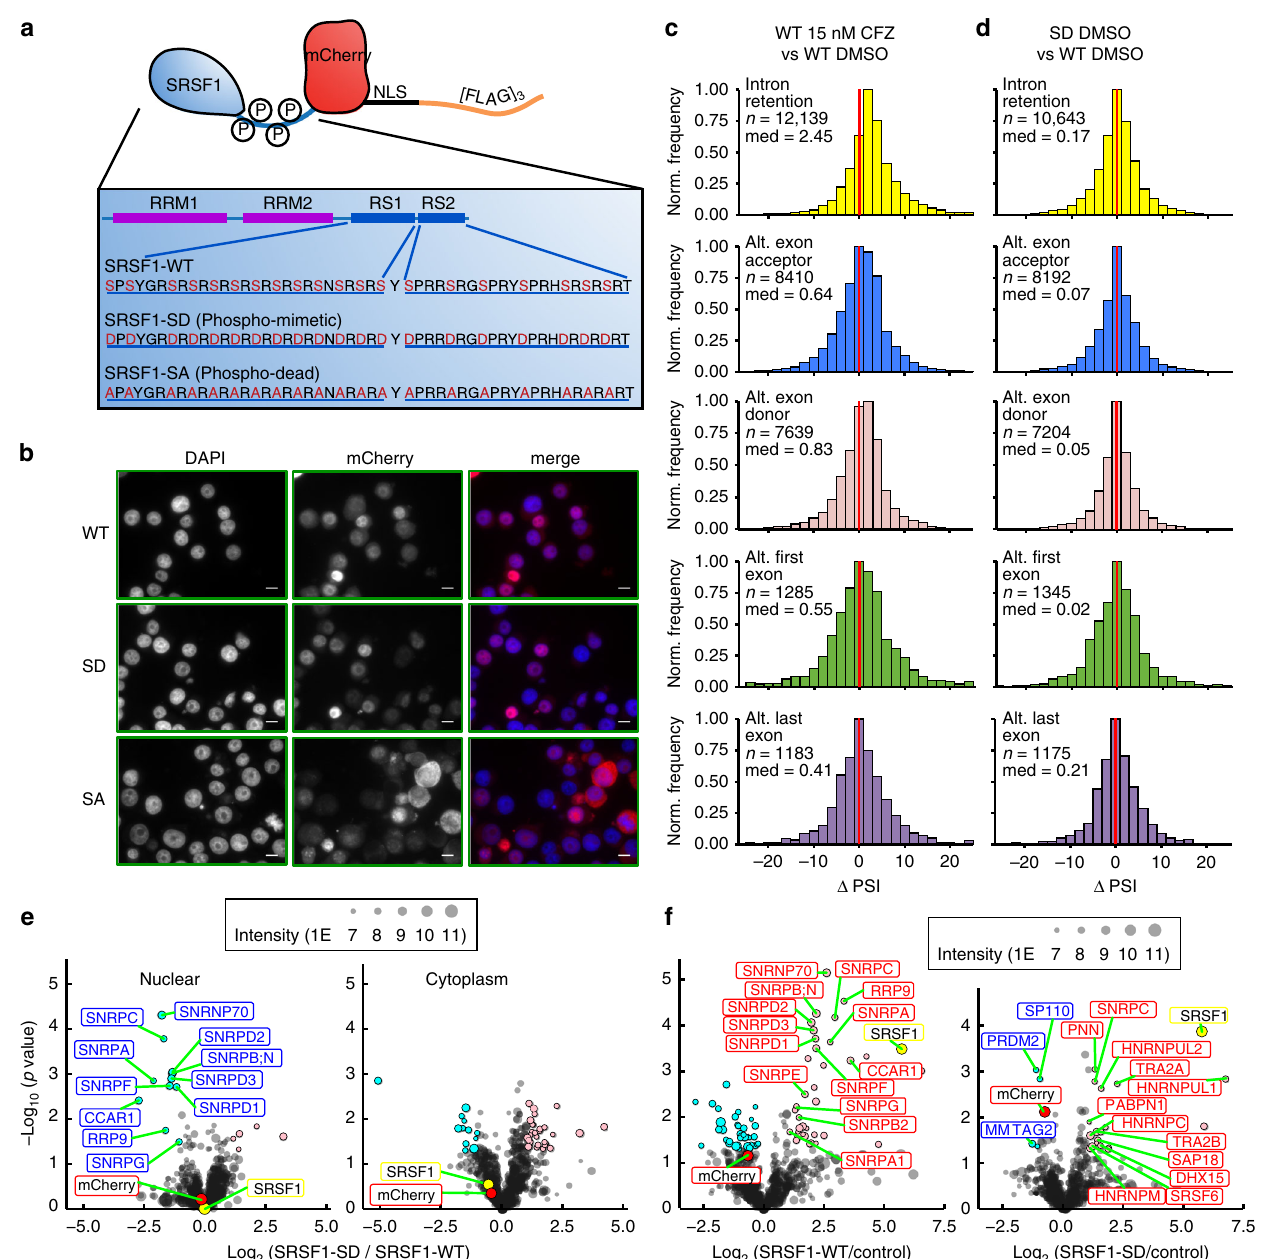
Fig. 4 Modeling SRSF1 phosphorylation in MM drives interactome dynamics but not global splicing changes. a Cartoon of protein architecture for SRSF1-NLS-mCherry-[FLAG] 3 . b Epi- fl uorescent images of DAPI-stained AMO-1-expressing mCherry-labeled SRSF1-WT (top panels), SRSF1-SD (middle panels), and SRSF1-SA (bottom panels). Scale bar represents 10 μ m, DAPI stain is pseudo-colored in blue and mCherry is pseudo-colored in red in the merged image, and micrographs represent experiments repeated twice with similar results. c , d Histograms of Δ PSI for IR, alt. exon donor, alt. exon acceptor, alt. fi rst exon, and alt. last exon ASEs when comparing differential splicing of AMO-1-expressing c SRSF1-WT treated with 15 nM Cfz to DMSO and d SD to WT. e Volcano plots indicating differential interactors of SD compared to WT in both the nucleus and cytoplasm. f Volcano plots of WT or SD when compared to control (NLS-mCherry-[FLAG] 3 ) in AMO-1 nucleus reveal SD exclusion from spliceosome. Signi fi cant enriched proteins in pink, unenriched proteins in cyan ( p < 0.05, ≥ 2-fold change). Circle size corresponds to summed LFQ intensities. mCherry ratio is red and SRSF1 ratio is translational machinery. We do note one stark difference between WT and SD mutant in the nuclear fraction: only the WT construct showed interaction with several small nuclear ribonu- cleoproteins, core components of the U1 – U2 spliceosome